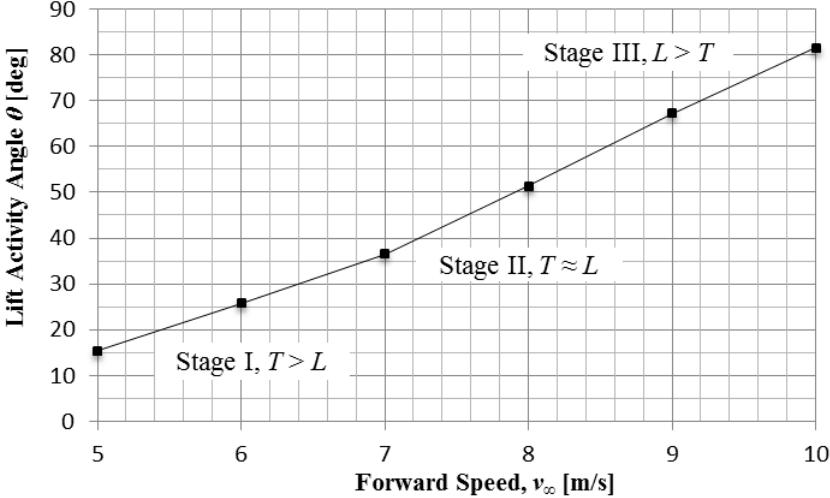
Figure 6. The lift activity angle θ at various forward speeds.